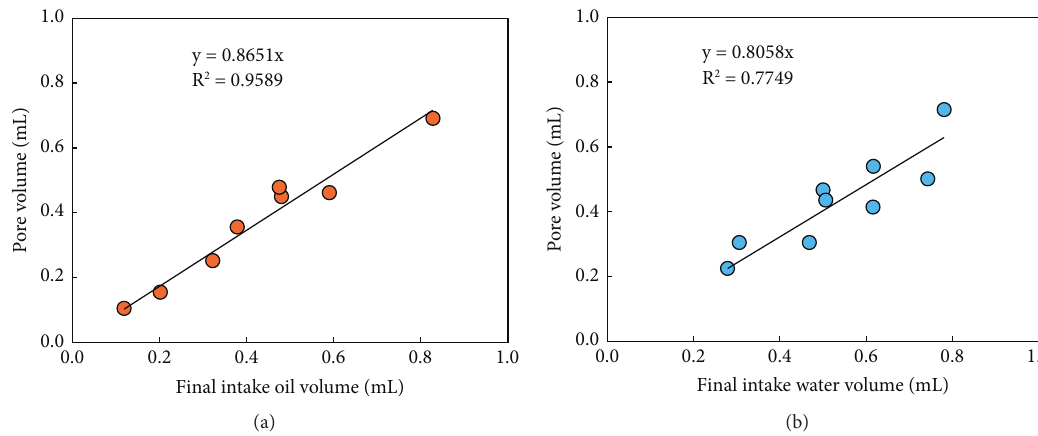
Figure 7: Correlation between imbibed liquid volume and pore volume. (a) Relationship between pore volume and oil imbibition volume. (b) Relationship between pore volume and water imbibition volume.